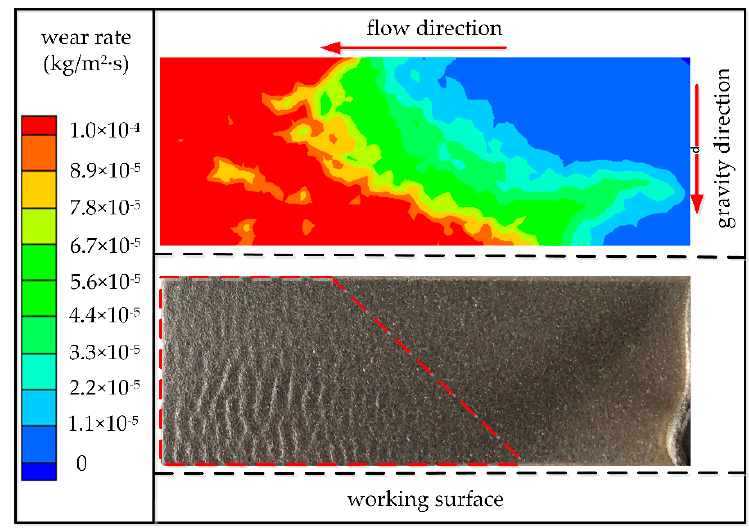
Figure 8. Comparison of wear area of blade working face at 500 rpm and 10% concentration.